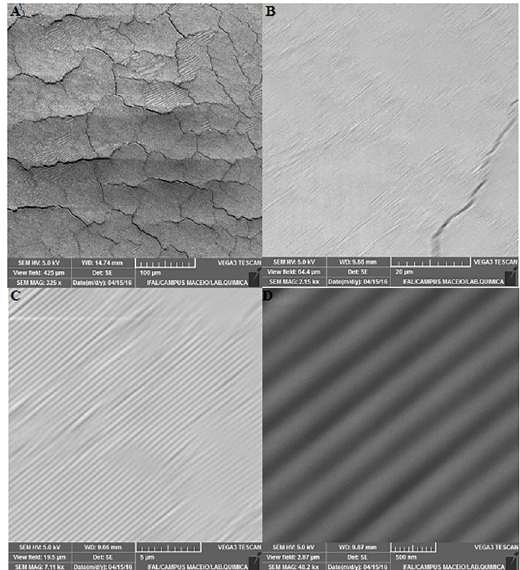
Figure 4. SEM microphotographies of latex beads film GSII at different magnifications: (A) - 325x; (B) - 2150x; (C) - 7110x; (D) - 48200x.